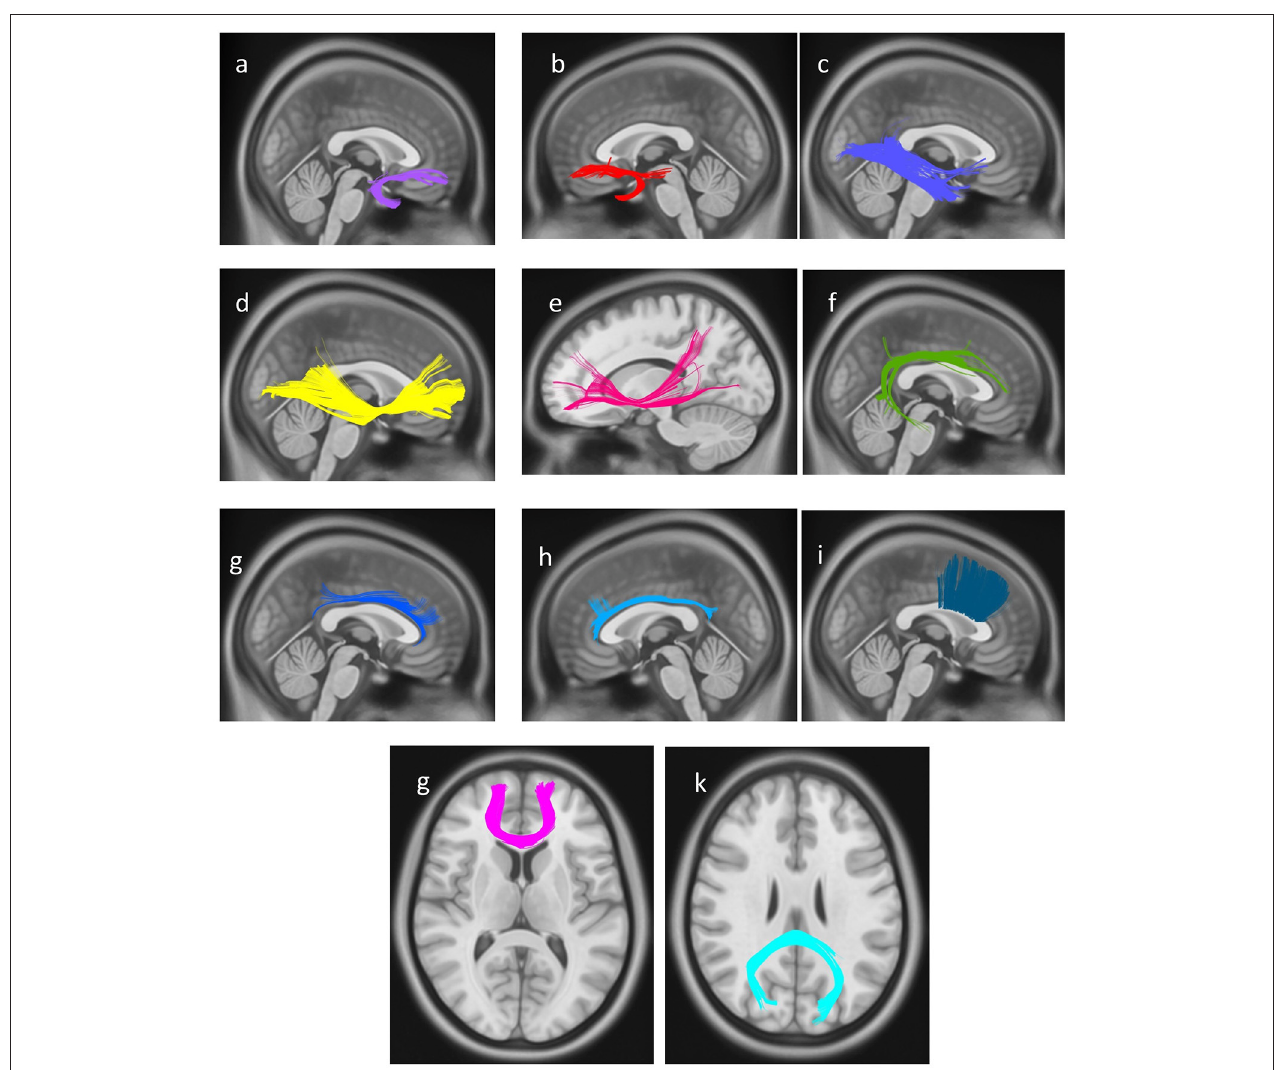
FIGURE 4 | White matter pathways with significantly increased connectivity in chess player’s compared to healthy controls ( FDR = 0.0285 ), (a) right uncinate fasciculus, (b) left uncinate fasciculus, (c) right inferior longitudinal fasciculus, (d) right Inferior fronto-occipital fasciculus, (e) left Inferior fronto-occipital fasciculus, (f) right arcuate fasciculus, (g) right cingulum, (h) left cingulum, and (i) body of corpus callosum, (g) genu of corpus callosum, (k) splenium of corpus